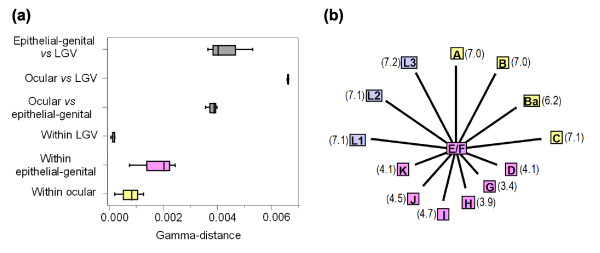
Impact of indel events on C. trachomatis's evolution and ecological success. (a) Evolutionary γ-distances for the global concatenated data within (colored boxes) and between (grey boxes) disease groups (ocular, epithelial-genital and LGV). Boxes represent the variability of all distance estimates, while the vertical line within each box divides 50% of all values. The minimum and maximum distances are represented by the extremes of each horizontal line. (b) Impact of indel events on C. trachomatis's ecological success. The mean γ-distances from any ocular (yellow), epithelial-genital (pink) or LGV (blue) strain to E/F strains are represented in parentheses. Each evolutionary distance was normalized against the distance between E and F. The relative length of each line is represented in the correct scale.